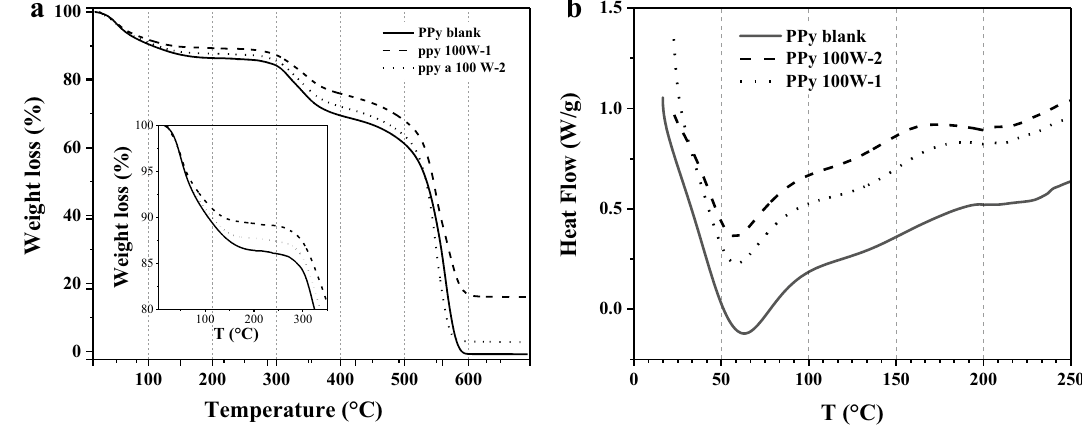
Fig. 4 a High-resolution XPS general spectra of ppy blank, ppy 100W-1 and ppy 100W-2. b High-resolution spectrum in the C 1 s region for ppy 100W-1 and ppy 100W-2. c High-resolution spectrum